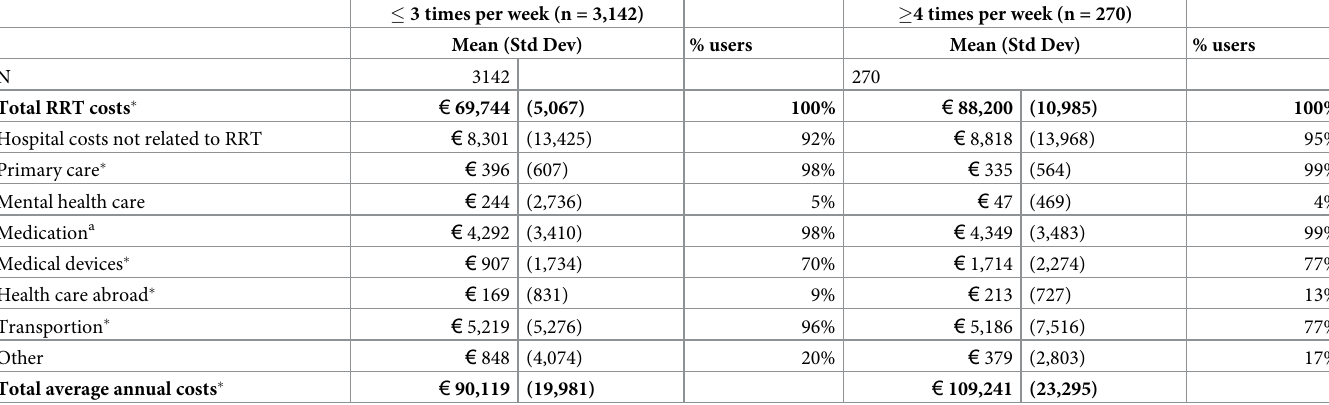
Table 3. Total average annual costs ( € ) depending on frequency of haemodialysis, for FYD patients (Full Year on Dialysis) only. � 3 times per week (n = 3,142) � 4 times per week (n = 270) Mean (Std Dev) %